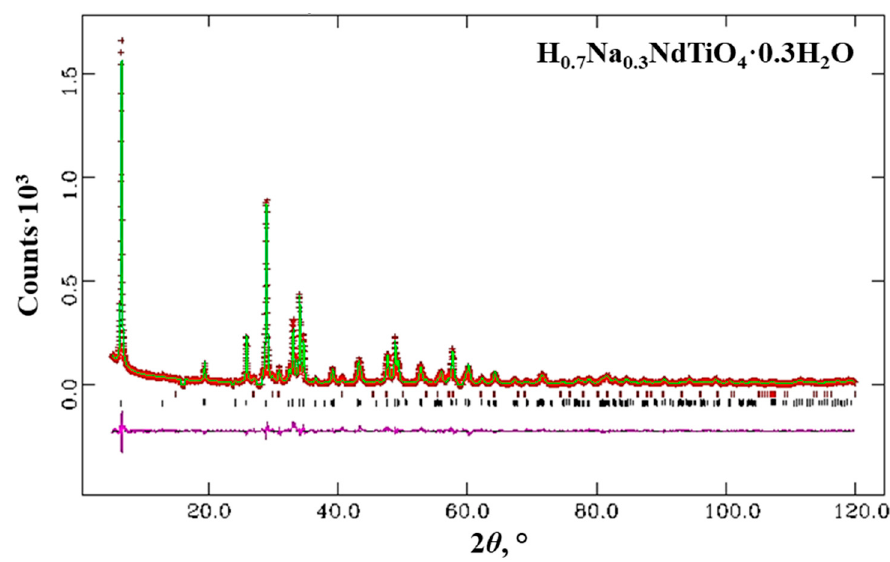
5 Figure 2. Thermogravimetric (TG) curves of partially and completely protonated samples. The structural model of the partially protonated titanate H 0.7 Na 0.3 NdTiO 4 ·0.3H 2 O was refined by the Rietveld method based on the XRD data (Figure 3) [62]. The XRD patterns